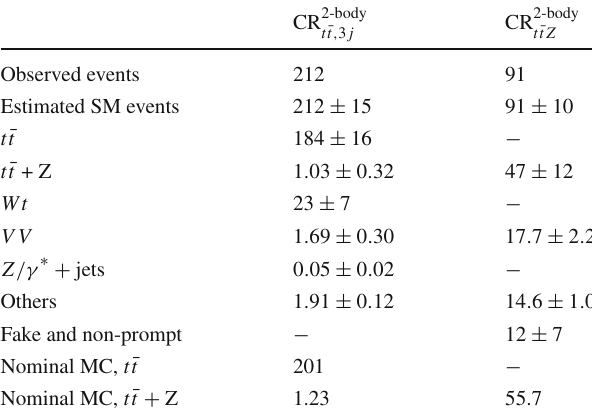
Table 8 Two-body selection background fit results for the CRs of the SRC 2-body